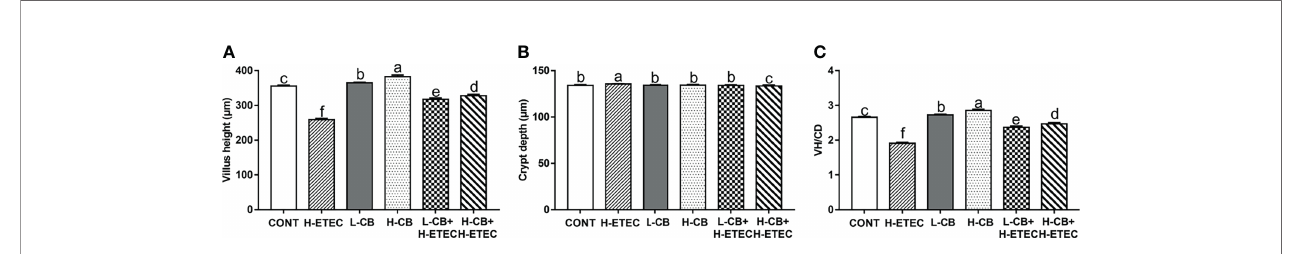
FIGURE 3 | Effect of CB and/or ETEC K88 on the jejunal form of mice. (A) villus height, (B) crypt depth, (C) VH/CD (n = 6 mice per group, n =12 villi and crypts per mouse). Values shown are the means ± SEM. Different small letters indicate signi fi cant differences ( p < 0.05).